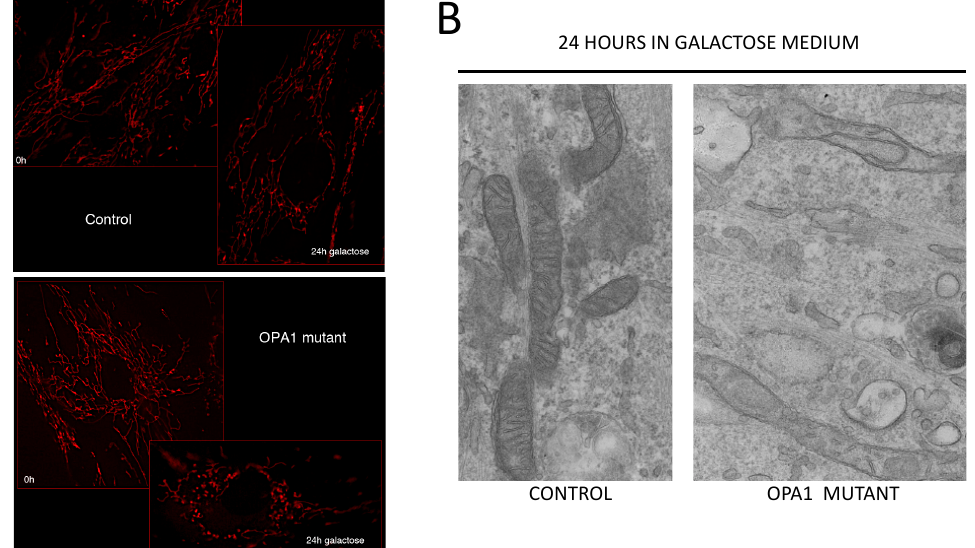
Figure 8. ADOA. ( A ): immunofluorescence with TMRM, a mitochondrion-specific dye. After 24 h exposure to a medium containing galactose, a carbon source that is energetically exploited only through OXPHOS, the mitochondrial network is similar to that of cells in normal glucose-containing medium in control cells, but appears severely fragmented in OPA1-mutant cells (see text for details). ( B ): The same experiment investigated the shape and internal structure of mitochondria. In OPA1 mutant cells, mitochondria are sparse and the cristae organization is severely disrupted, compared with a control sample (detail inset modified from supplemental material from Zanna et al, 2008 [120]).